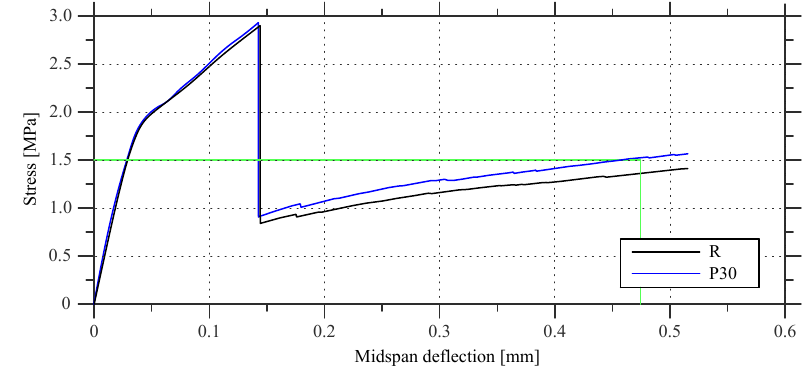
Figure 3. Normal tension as a function of midspan